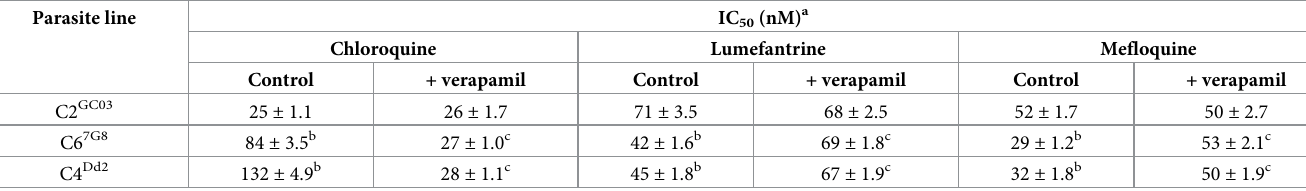
Table 1. In vitro antiplasmodial activities of chloroquine, lumefantrine, and mefloquine against P . falciparum pfcrt transfectant lines. Parasite